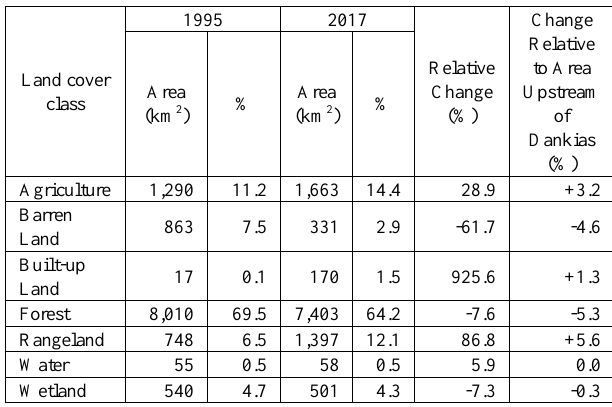
Table 5. Summary of classification area statistics for 1995 and 2017 for the portions of ARB upstream of Dankias Station.